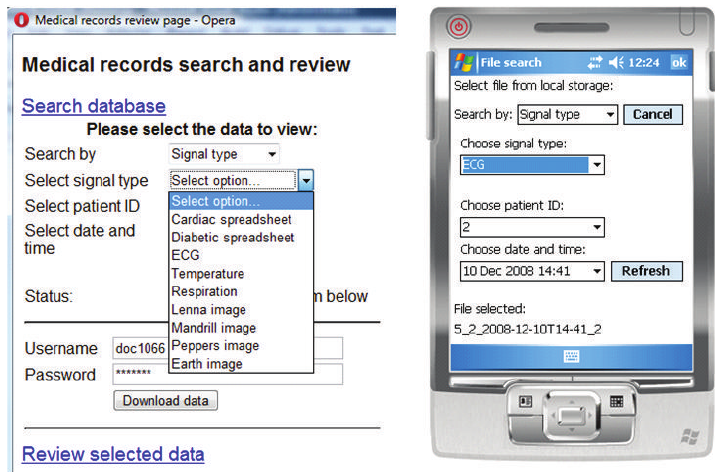
Figure 2: Example of database search on browser (left) and PDA application (right).